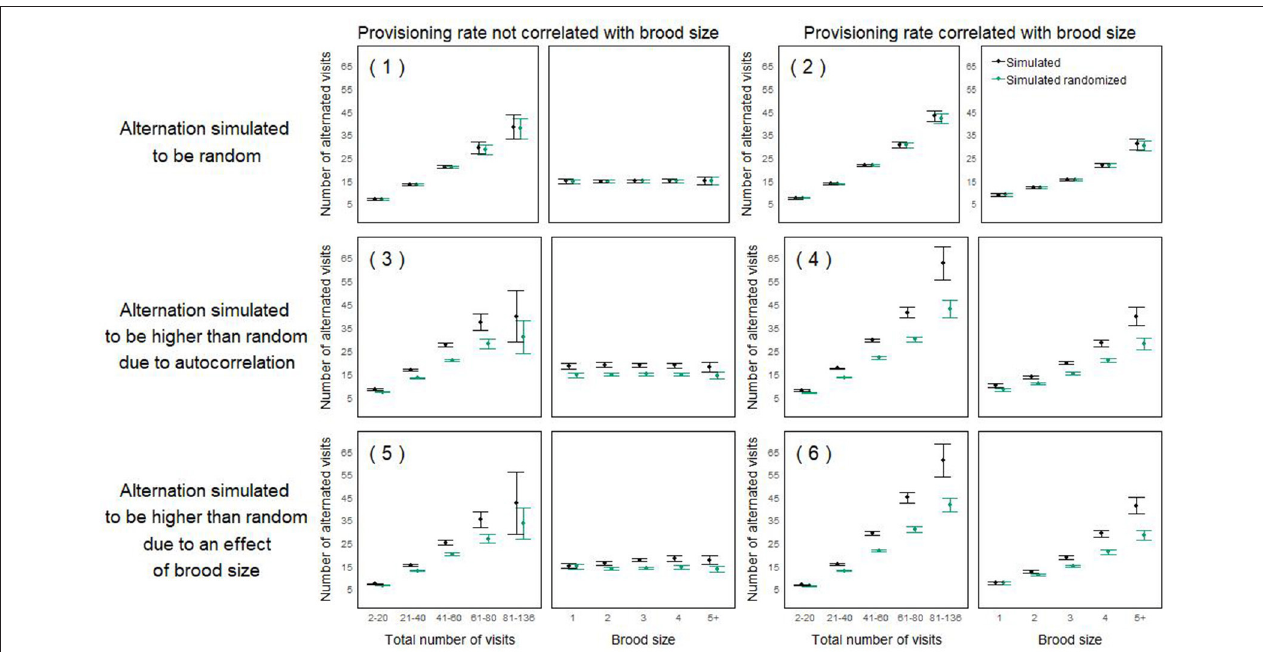
FIGURE 5 | Mean number of alternated visits in simulated nest watches ( ± 95% CI) as a function of the total number of visits (left panels) and brood size (right panels). For each scenario (half rows, with number referring to the scenarios described in Table 1 ), we plotted the alternation of one representative simulated dataset of 1,599 nest watches (chosen randomly among 10 simulations which all appeared to be qualitatively similar; in black), as well as the alternation obtained after randomizing that simulated dataset (according to the within-individual randomization procedure; in green), which can be used as a baseline expectation. For all three scenarios on the left hand-side, the provisioning rate was not simulated to be correlated with brood size. For all three scenarios on the right-hand side, the provisioning rate was simulated to be correlated with brood size. For scenario 1 and 2 (top row) alternation was simulated to be random, for scenario 3 and 4 (middle row), alternation was simulated to be higher than expected by chance due to correlation in directional changes, for scenario 5 and 6 (bottom row), alternation was simulated to be higher than expected by chance due to an effect of brood size. An appropriate analysis should only detect an effect of brood size on alternation in scenario 6, where it was specifically simulated. The total numbers of visits were categorized in increments of 20; simulated nest watches with more than 100 visits (between 6 and 20 cases) were pulled into the last category (“81–136”). Nest watches with more than 5 nestlings ( n = 4) were pulled into the category “5 + ” nestlings.